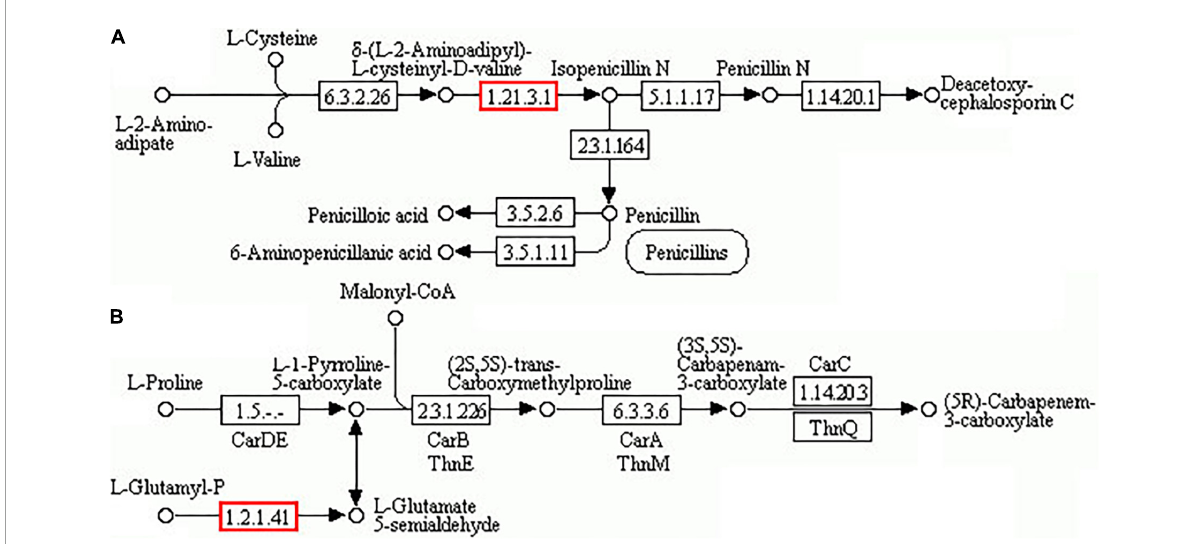
FIGURE6 “Biosynthesis of antibiotics” pathway. (A) Biosynthesis of penicillin and cephalosporin. (B) Carbapenem biosynthesis.